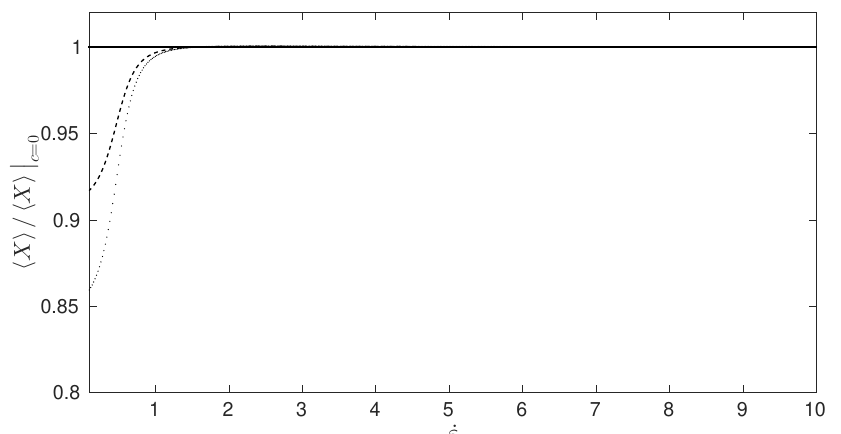
Figure 7. The mean horizontal extension scaled by the infinitely dilute case plotted against ˙ ε where the mean-field term has been set to zero. The results are given for c dashed, and dotted lines,